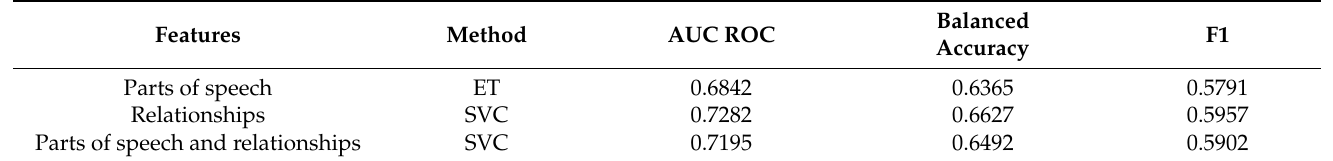
Table 4. The results of classifications by parts of speech and relations for the main data